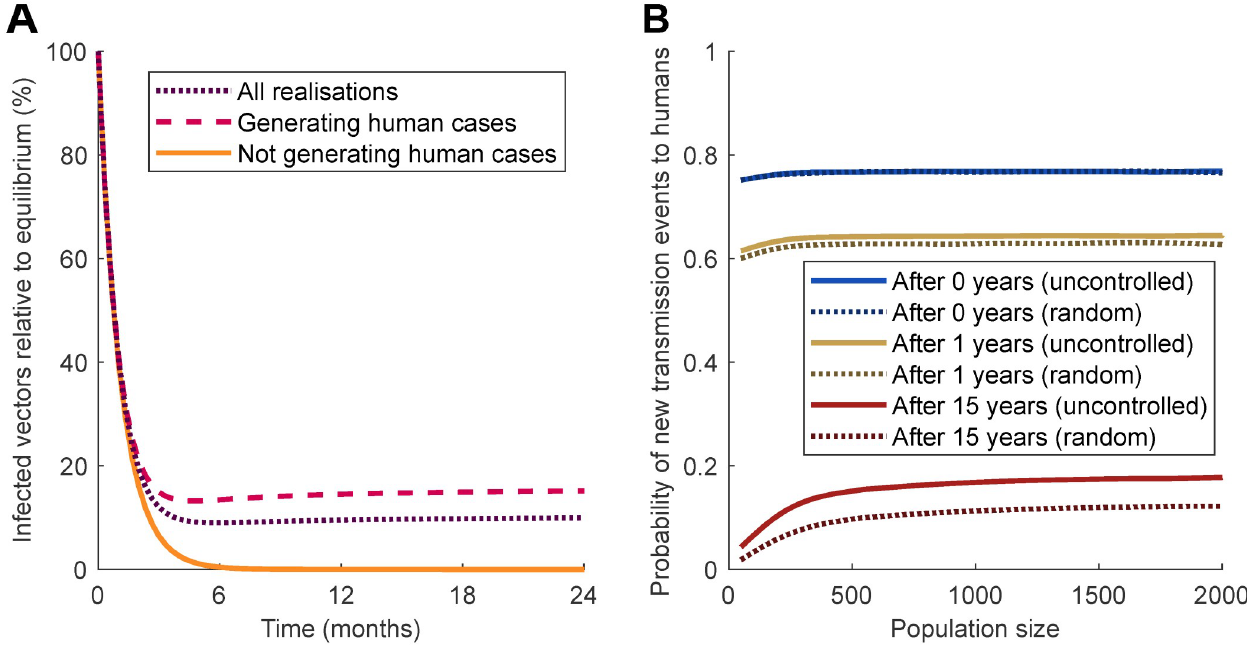
Fig 4. Dynamics of extinction and reintroduction. (A) Starting with no infected humans but the tsetse population at its endemic equilibrium and a settlement size of 1,000 individuals, the model predicts a dramatic decline in the infected tsetse population, depending on whether subsequent human cases are generated by the infected tsetse. (B) Extending this model further for a range of initial conditions, we examine the probability that at least one human case is generated and the infection persists for a given time, when starting with one infected human and no infected tsetse for both uncontrolled and random